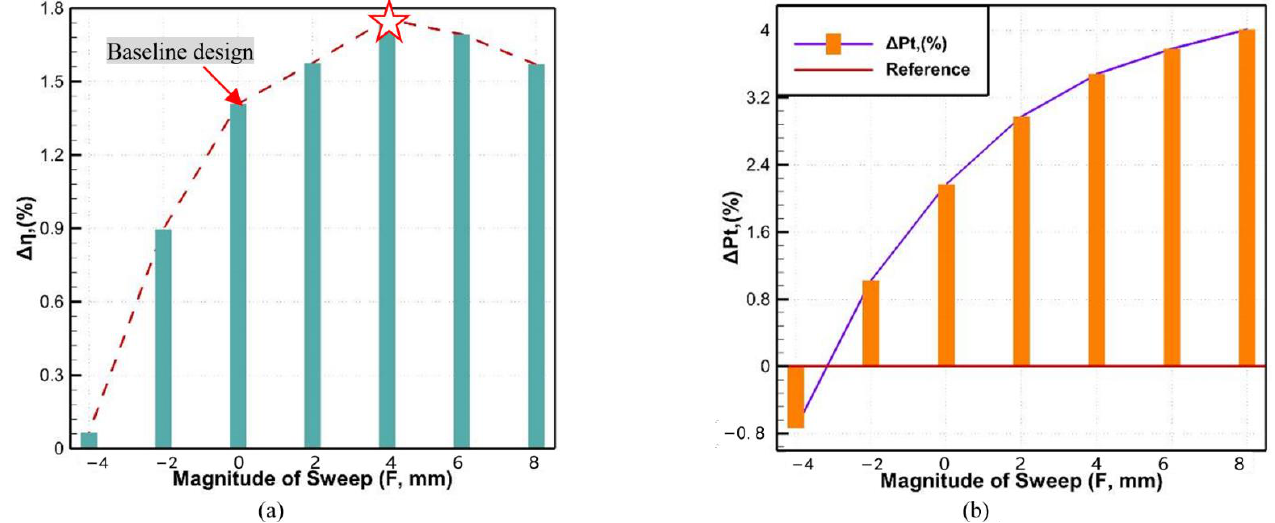
Figure 18. The effect of inducer sweep on the compressor performance at the P.E. points. ( a ) Isentropic efficiency, and ( b ) total pressure ratio.